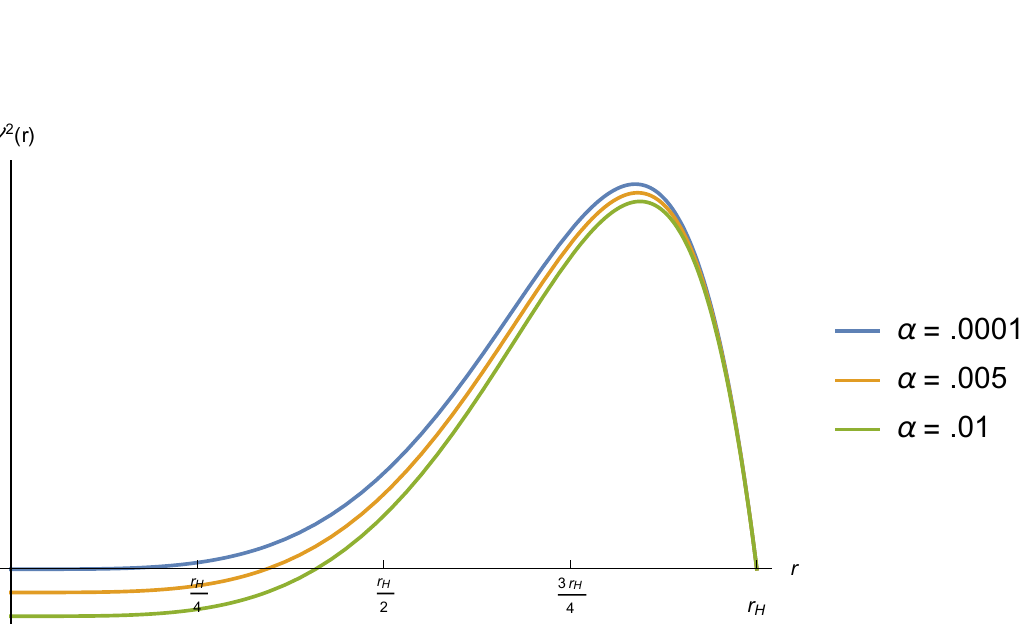
2 ( r ) of the volume functional for the α -corrected AdS-Schwarzschild Figure 6. The square V geometry in the GB theory, plotted for several values of α (labeled).